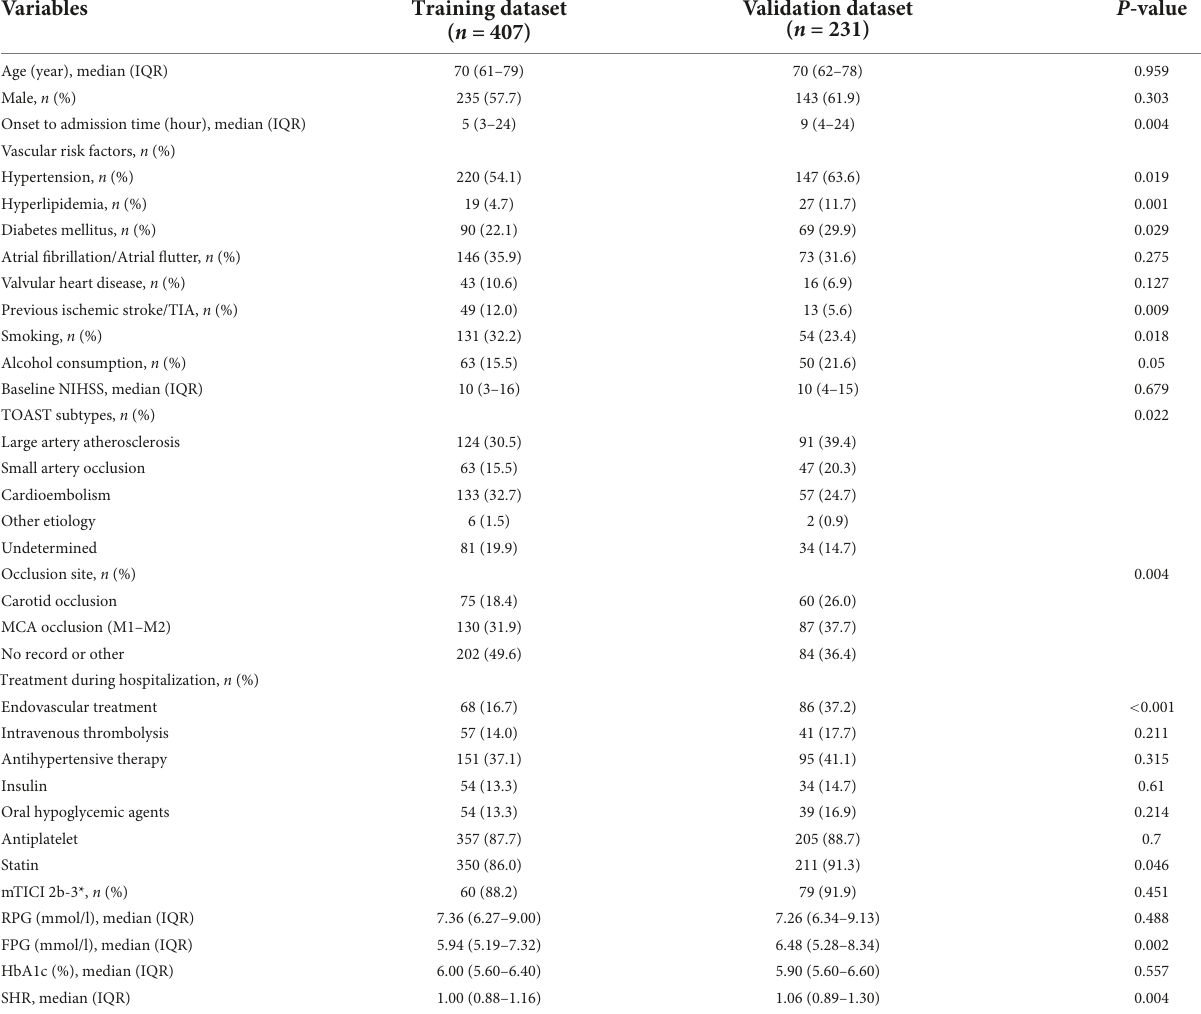
TABLE 1 Baseline characteristics of the training dataset and validation